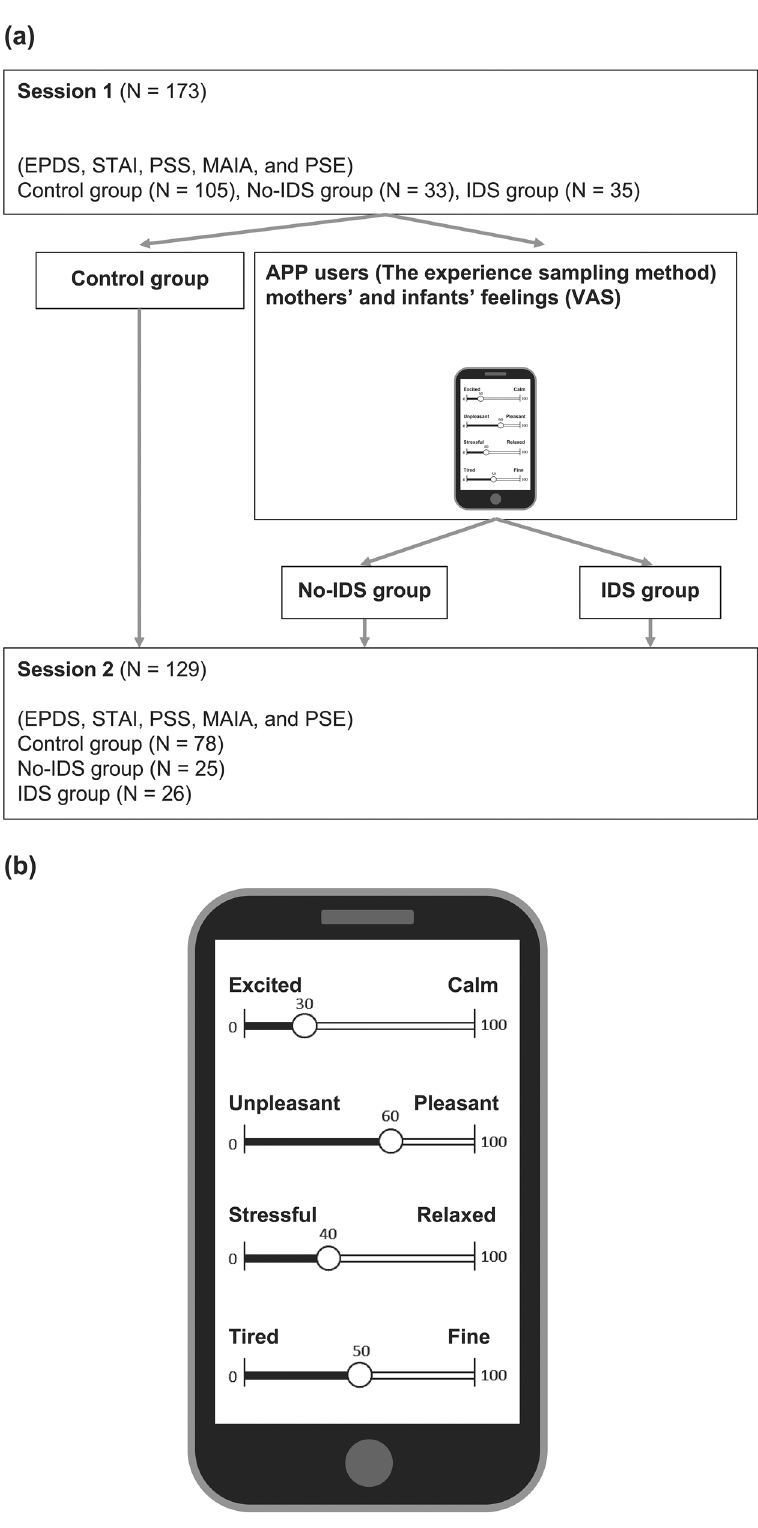
Figure 5. Explanation of the research flow and the smartphone application screen. ( a ) Research flow chart and ( b ) VAS answer screen about mothers’ and infants’